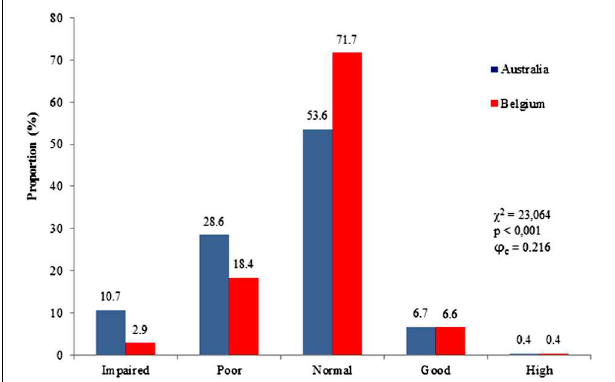
FIGURE 1 | Proportion of children across KTK performance ratings for both countries.